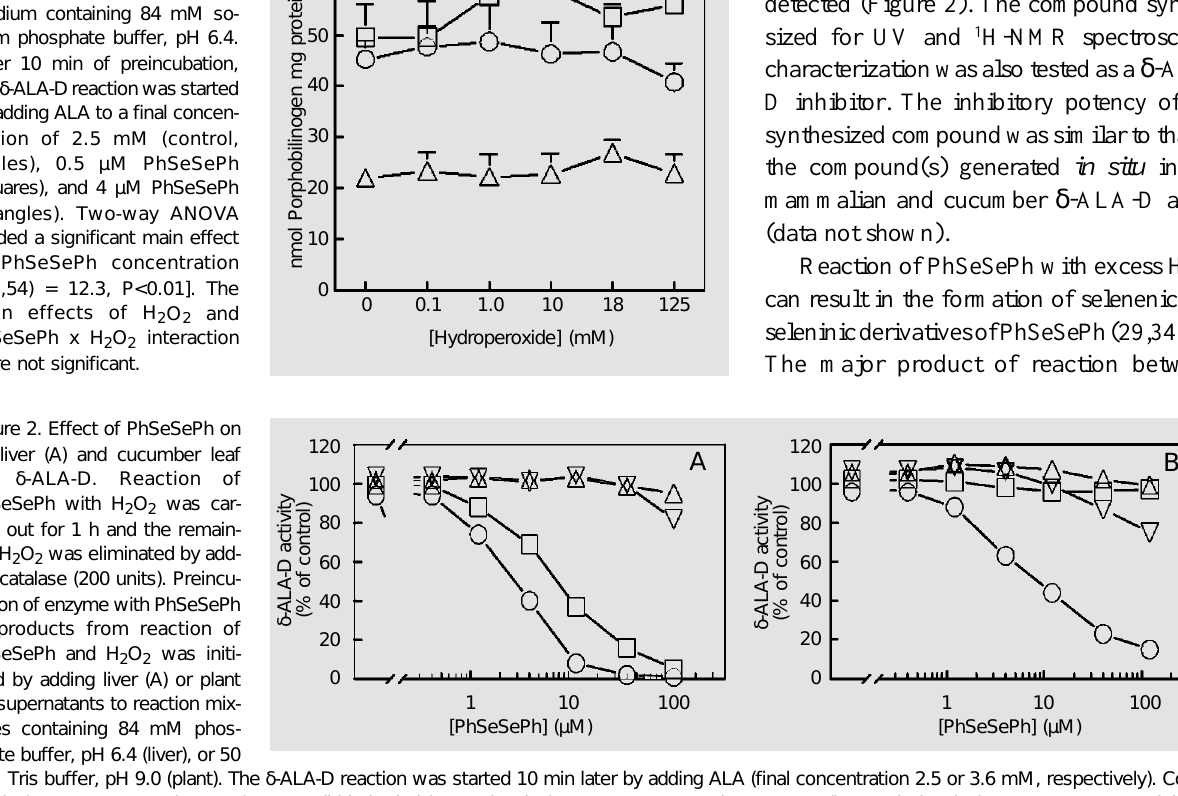
1. Effect of H 2 O 2 and PhSeSePh on rat liver δ -ALA-D.